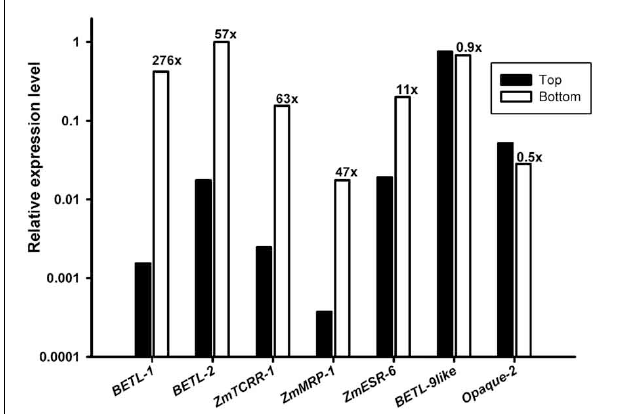
FIGURE 2 | Expression analyses of the marker genes in wild type kernel halves. RNA from the upper ( Top , black bars) and lower ( Bottom , empty bars) halves of 10 DAP wild type kernels was used as template for the markers indicated in the X axis. The Y axis scale is logarithmic (base 10). The ratio Bottom/Top found for each marker is indicated above each empty